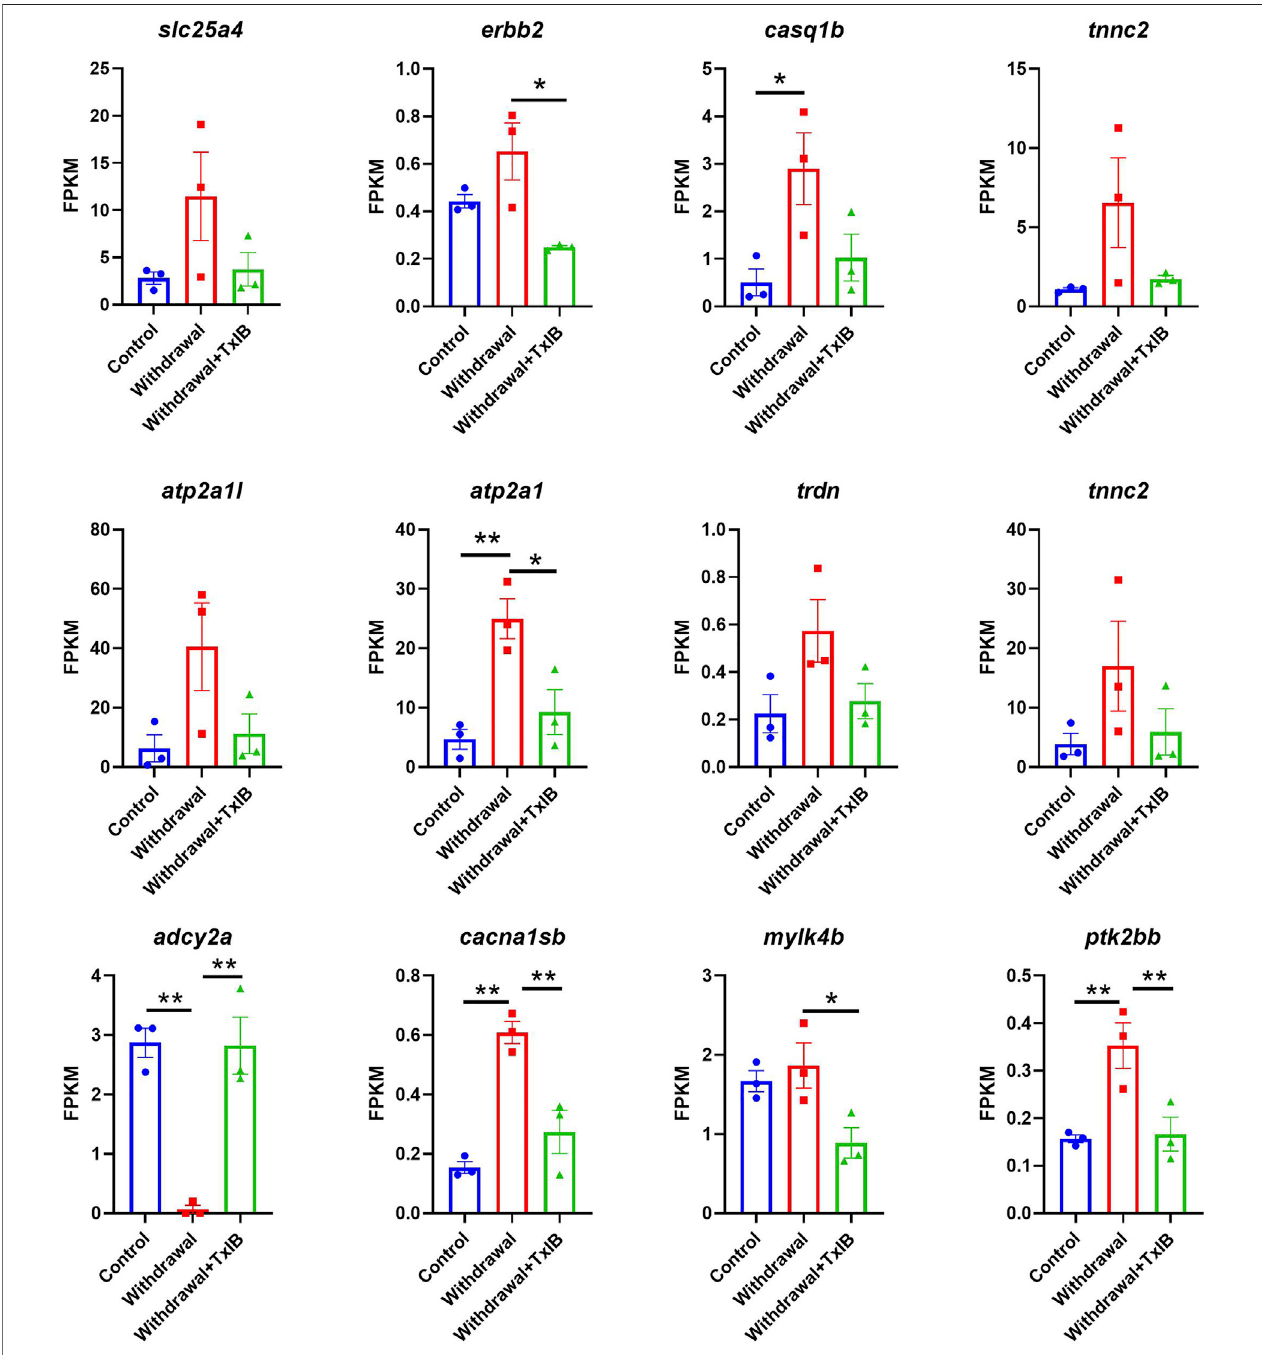
FIGURE5| Therelativeexpressionpro fi leofgenesenrichedinthecalciumsignalingpathway.Dataaremean ± SEMof3samplespergroup.*indicates p < 0.05,** indicates p < 0.01 (one-way ANOVA followed by Tukey ’ s multiple comparisons test).